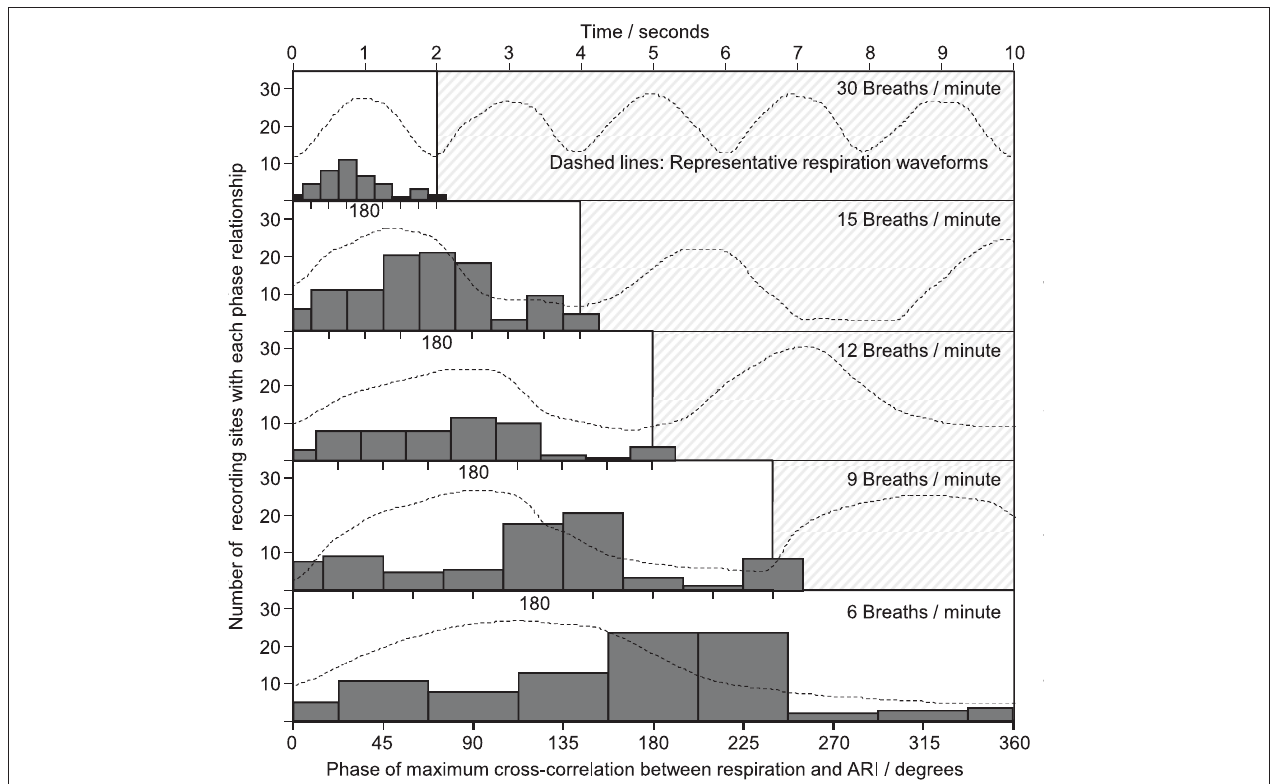
FIGURE 7 | Phase relationships obtained from cross-correlation between respiration and ARI. As with Figure 6 , a common horizontal time axis is used, and typical respiratory waveforms are shown, with one cycle highlighted. At each respiratory rate, one cycle is divided into 9 ranges (with 0 and 360 ◦ shown separately) and a histogram collates the phase lags